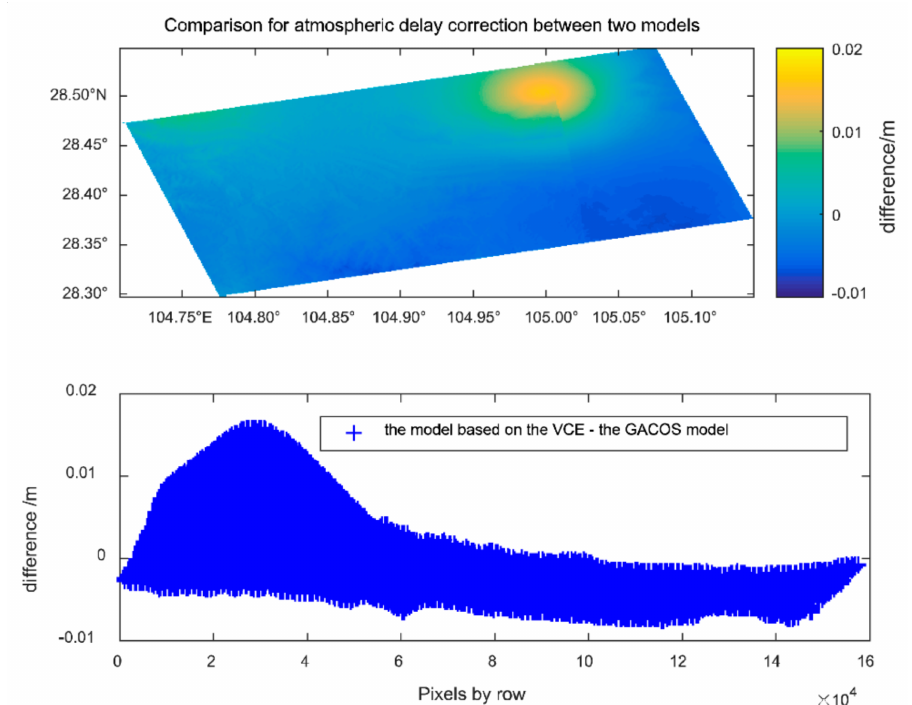
Figure 4. Comparison for atmospheric delay correction between the variance component weighting model and the GACOS model: the top shows the difference between the two models in the area of interest; the color − coded strips represent the difference between the atmospheric delay correction model, based on the VCE method, and the GACOS model; the vertical axis and the horizontal axis represent the northern latitudinal range and the eastern longitudinal range of the study area, respectively; at the bottom is the difference between the two atmospheric delay correction models in the corresponding pixels: the horizontal axis represents the pixels extracted by row, and the vertical axis represents the difference values; the unit is